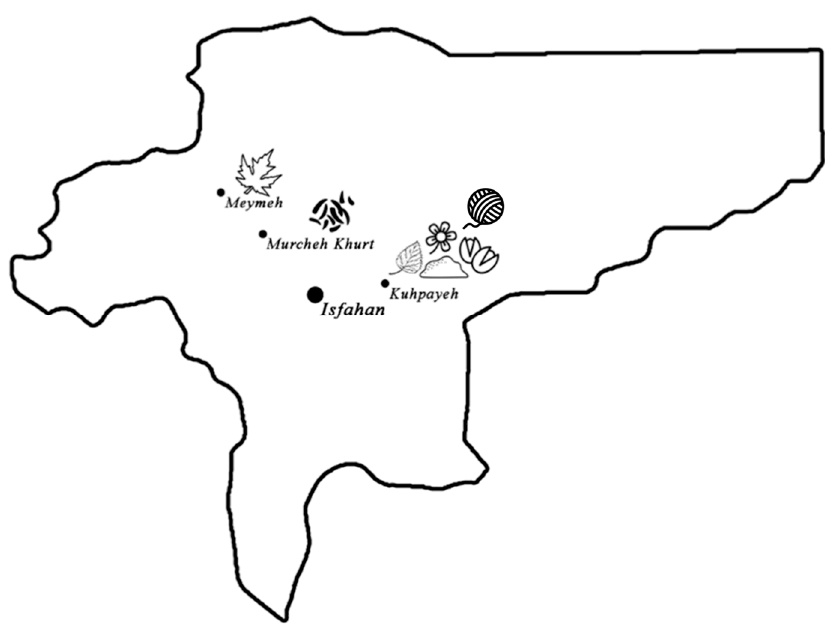
Figure 5. Geographical distribution of the collected plant sources used to dye yellow in Isfahan province, Iran [31].